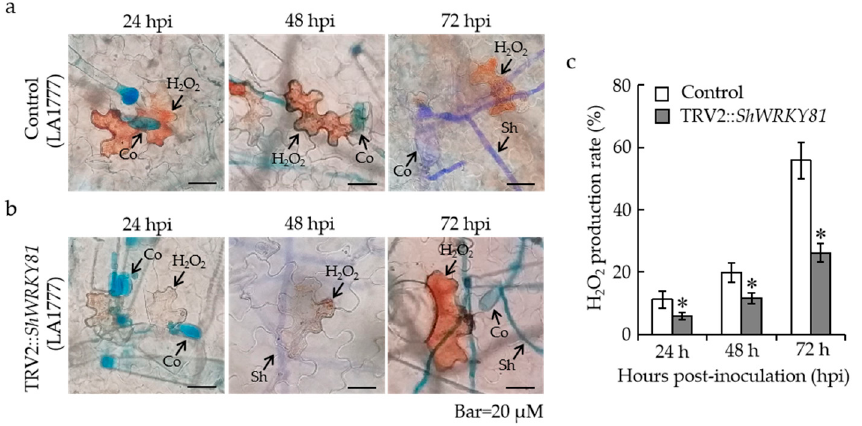
Figure 6. The silencing of ShWRKY81 decreased the production of H 2 O 2 in LA1777 following On -Lz infection. Histological observation of H 2 O 2 accumulation at infection sites of On -Lz in control ( a ) and ShWRKY81 -silenced LA1777 seedlings ( b ). The H 2 O 2 production rates were calculated at 24, 48, and 72 hpi ( c ). Co, conidium; Sh, secondary hyphae. Bar, 20 µM. Values are shown as the means ± standard error of three biological replicates, and statistically significant differences are represented by asterisks (Student’s t -test, *, p < 0.05).